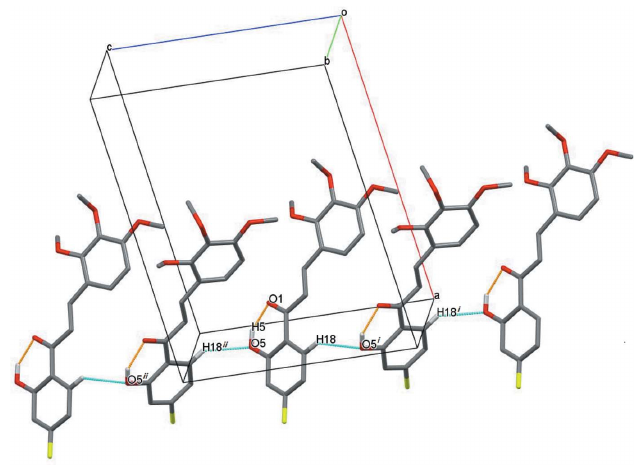
Figure 2 Part of the crystal structure with the intramolecular O—H (cid:3)(cid:3)(cid:3) O hydrogen bond and weak C—H (cid:3)(cid:3)(cid:3) O hydrogen bonds shown as dashed lines. For the sake of clarity, only the H atoms involved in hydrogen bonds are shown [symmetry codes: (i) x , (cid:4) y + 1